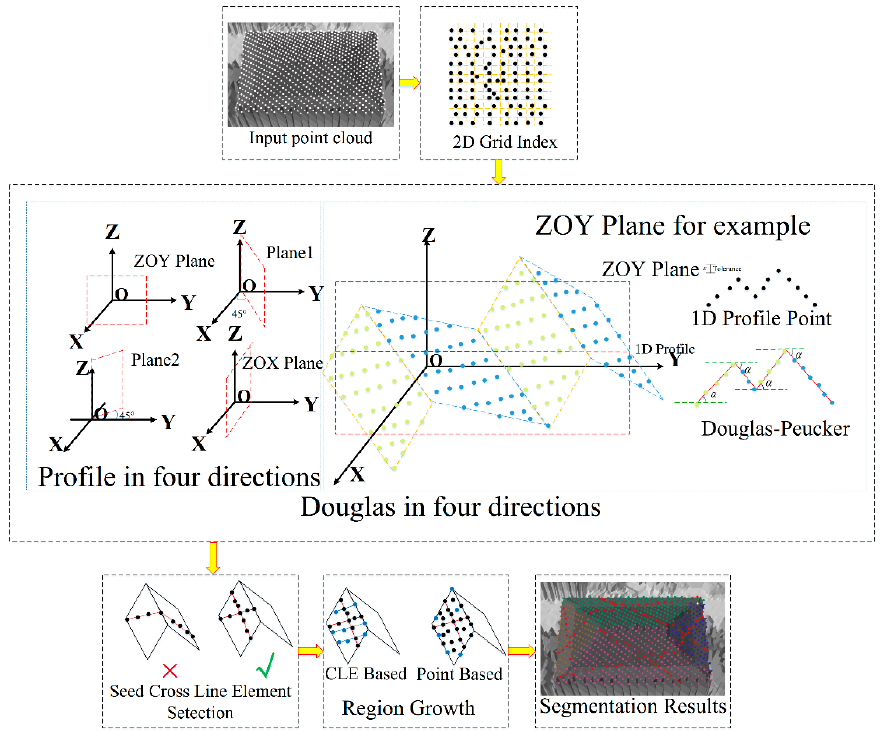
Figure 1. Workflow of plane segmentation using cross-line elements.